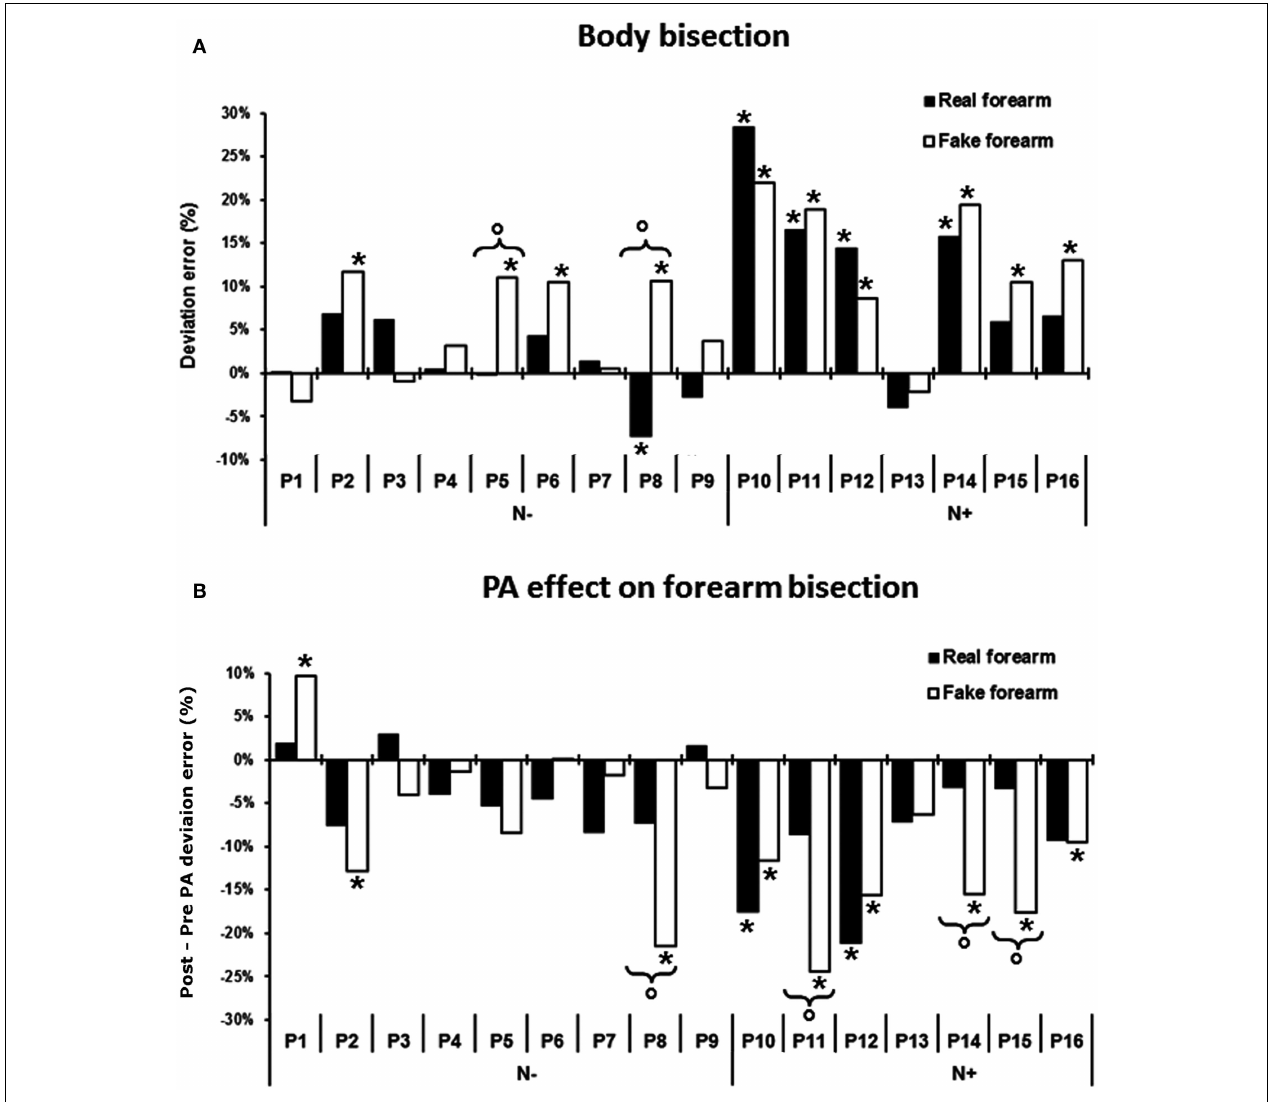
rightward effect. Asterisk: significant difference between each patient’s score and the mean score of the control group for each stimulus condition. Circles and brackets: significant difference between fake and real forearm bisection in the individual patient, as compared to the same average difference in the control group. N − , patients without USN; N + , patients with